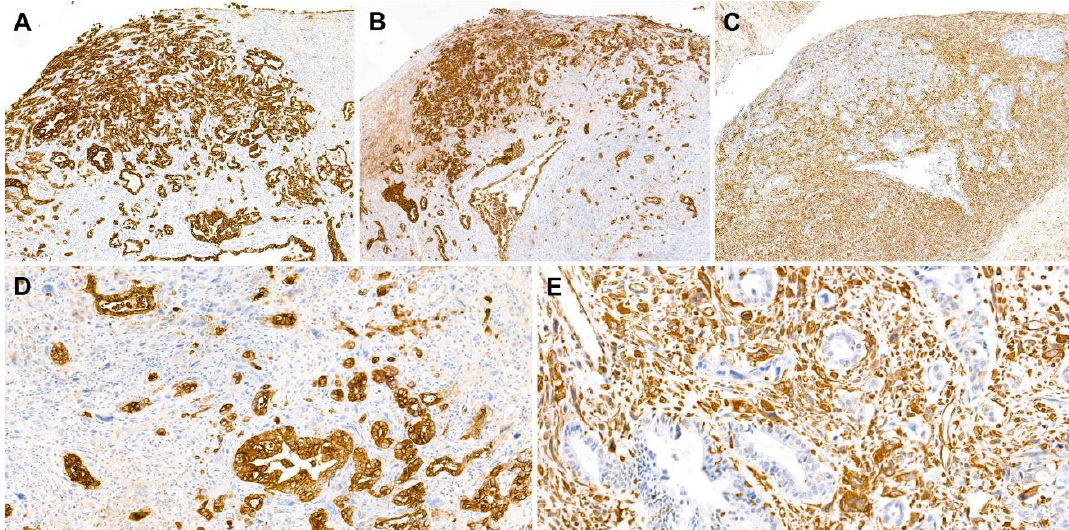
Figure 4. Immunostaining results. ( A , B ) The carcinomatous component was highlighted using ( A ) cytokeratin 7 and ( B ) epithelial membrane antigens. ( C ) The sarcomatous component reacted